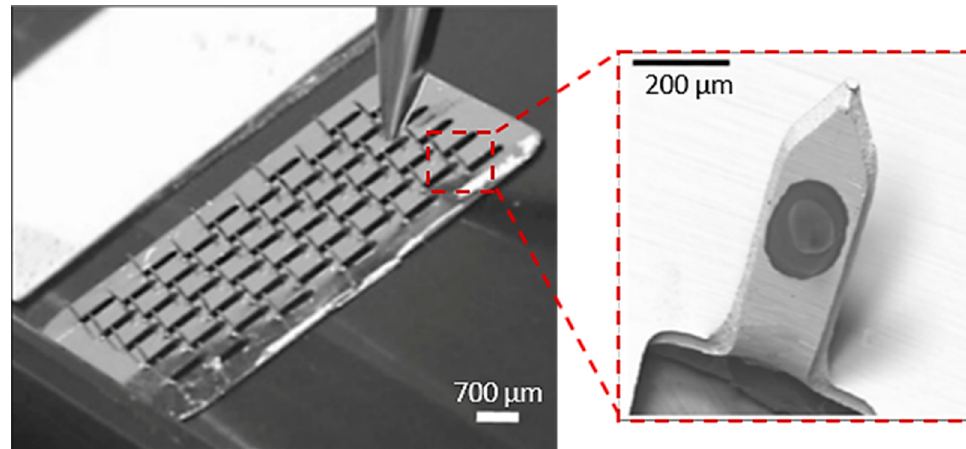
Figure 7. MNs arrays, used as drug carrier of anticancer drug formulations, (50 needles in total) produced by laser cutting method by cutting the shape of the needles in the stainless steel sheet and bent the needles out of plane at 90°. Reprinted with permission from Ref. [114]. 2015, Elsevier.